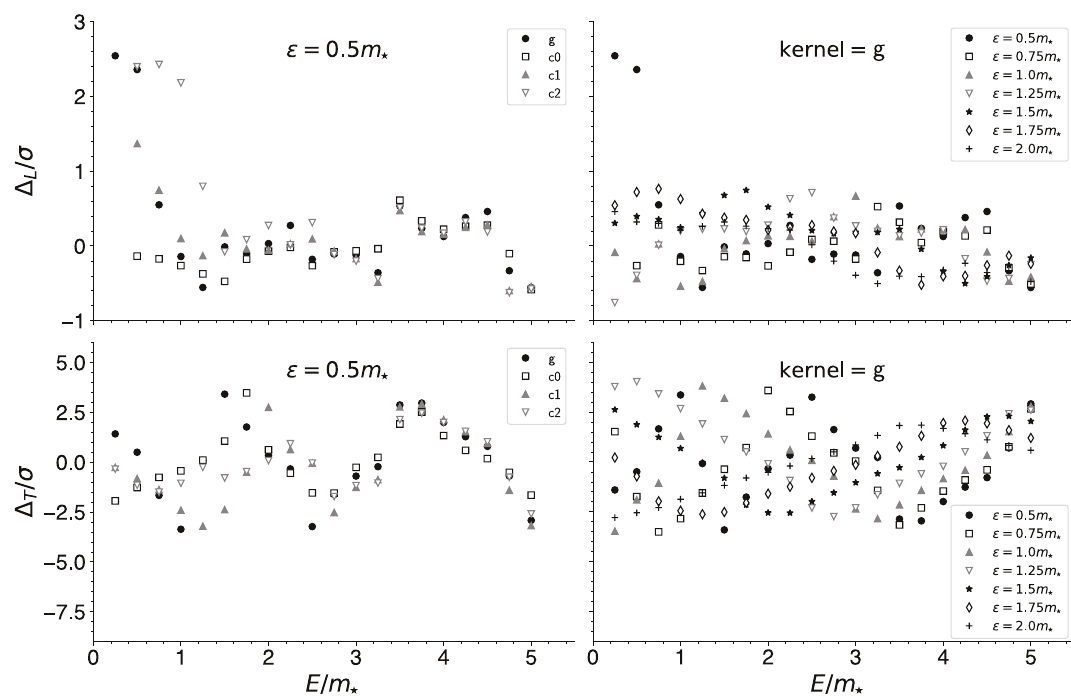
Figure 4 . The differences ∆ L and ∆ T from eq. (5.1). The vertical axis is normalized by the error on the estimated difference and can be interpreted as the statistical significance of each of the finite size effects. The sum of the mean values | ∆ L | + | ∆ T | is taken as an estimate of the systematic error due to finite size effects independently for each E , (cid:15) , and smearing kernel.